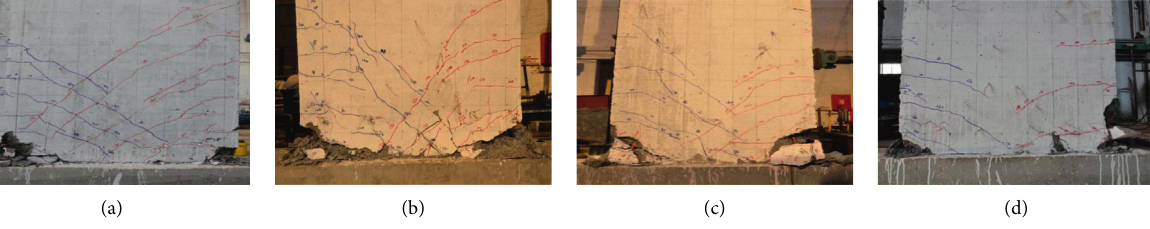
Figure 4: Test piece failure form. (a) W01. (b) W02. (c) W03. (d) W04.